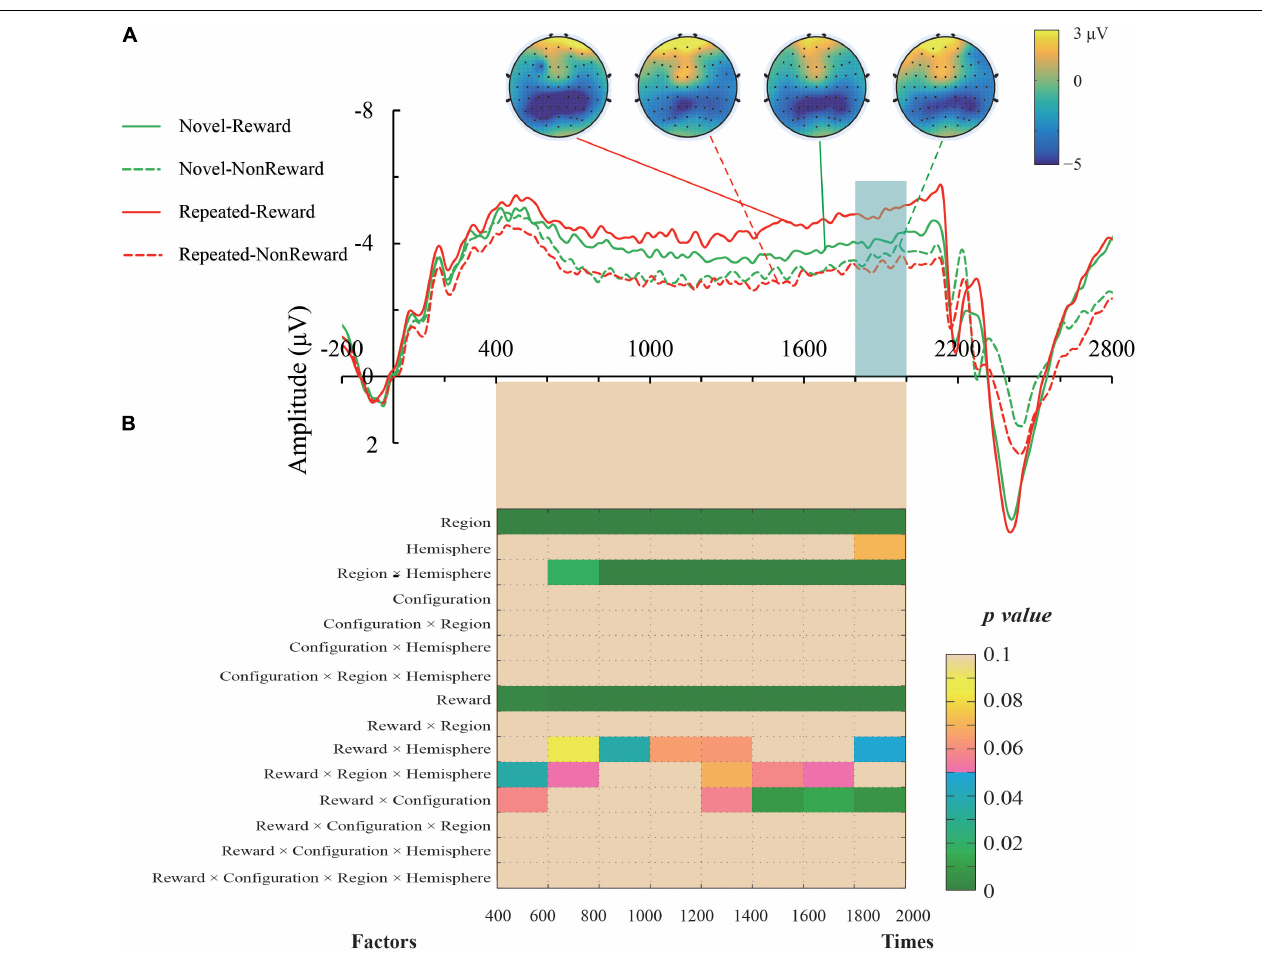
FIGURE 2 | (A) Grand average event-related potentials (ERPs) elicited by the anticipation of feedback for each configuration and the reward condition. The stimulus-preceding negativity (SPN) components, which are highlighted by a light gray box, were ranged from 1,800 to 2,000 ms after the anticipants’ response (i.e., 200 to 0 ms before the feedbacks’ appearance). The topographic maps from left to right were the Repeated-Reward, Repeated-Non-reward, Novel-Reward, and Novel-Non-reward conditions at 190 ms before the feedback onset. (B) The statistical p -values of SPN mean amplitudes were analyzed every 200-ms interval from 400 to 2,000 ms after response onset. Four within-subject factors of repeated-measures ANOVAs designed for Configuration (Repeated/Novel), Reward (Reward/Non-reward), Region (central, centroparietal, parietal), and Hemisphere